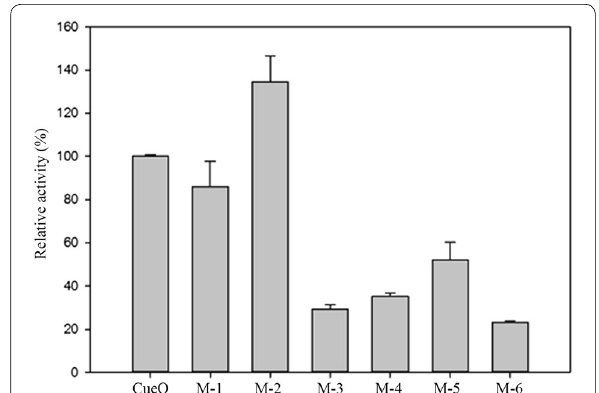
Fig. 2 Relative laccase activity of the CueO mutants compared to wild type at pH 4.5 and 60 °C. The relative laccase activity in the supernatants was determined using standard enzyme assays and shown on the y -axis. Enzyme activity is expressed as the mean of three samples, and error bars indicate standard deviation